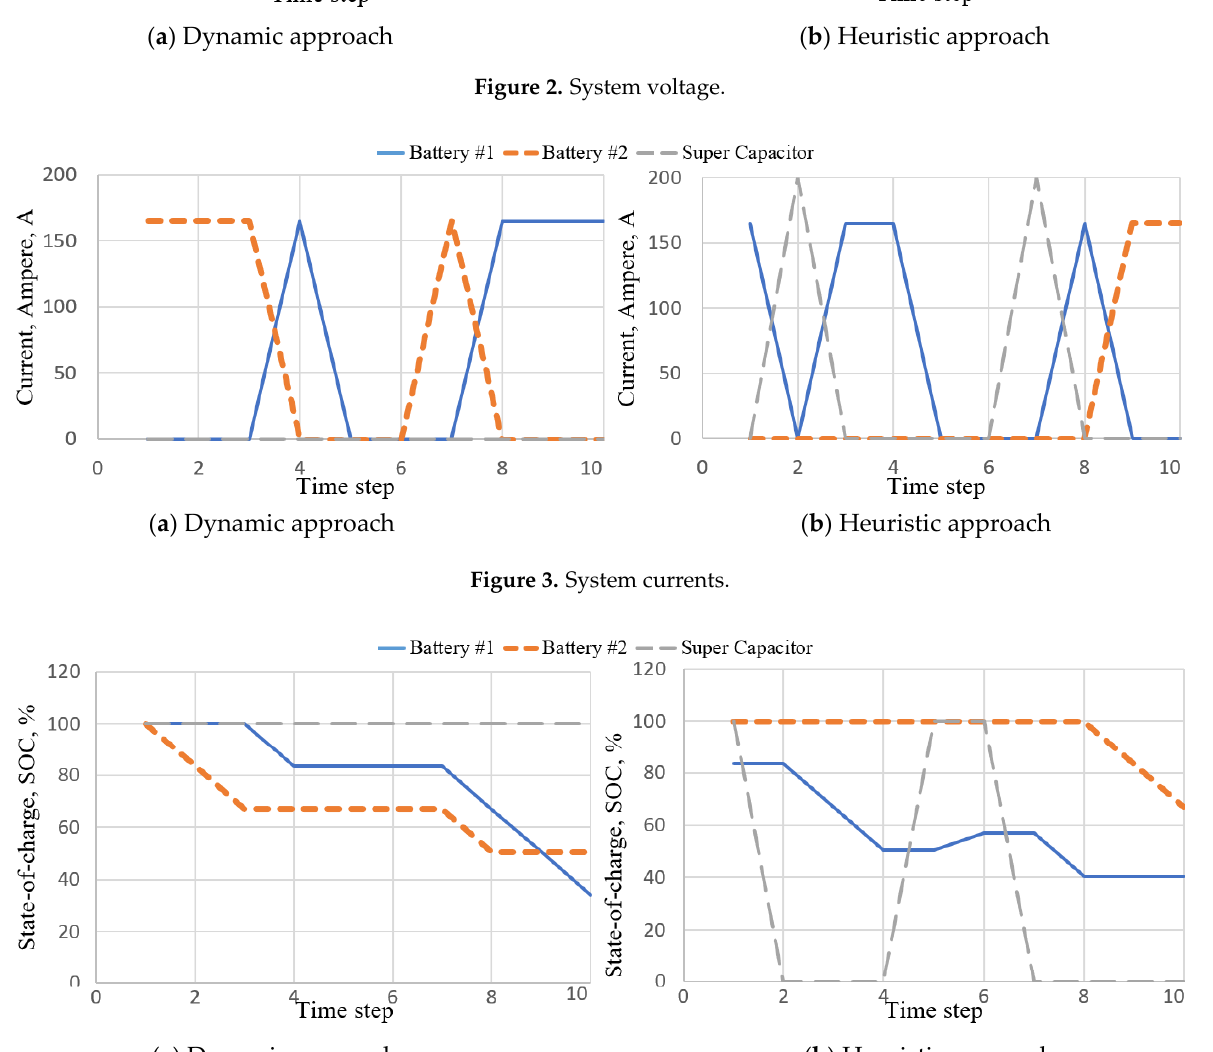
Figure 4. System state-of-charge.